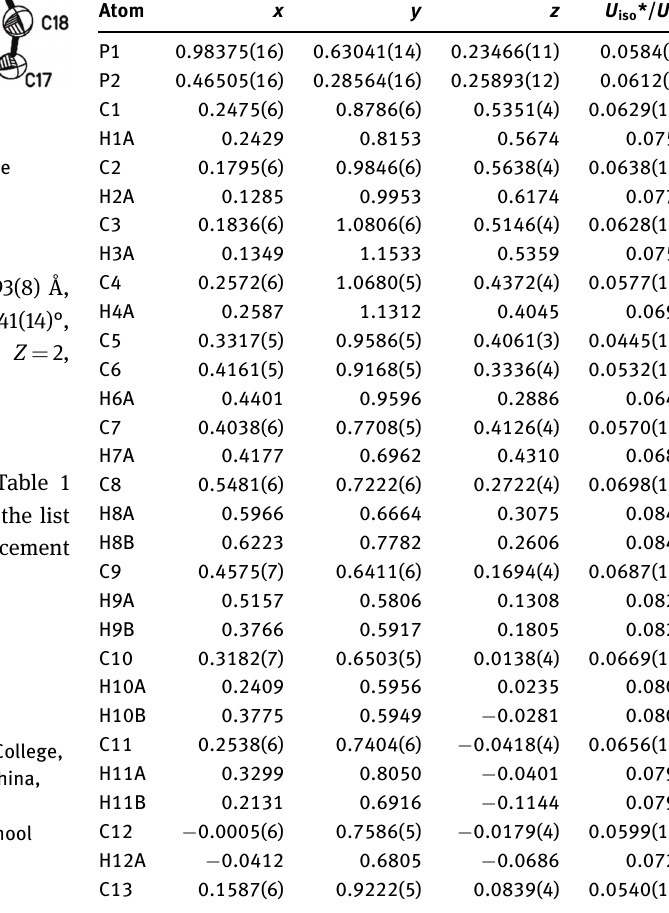
Table 2: Fractional atomic coordinates and isotropic or equivalent isotropic displacement parameters (Å 2